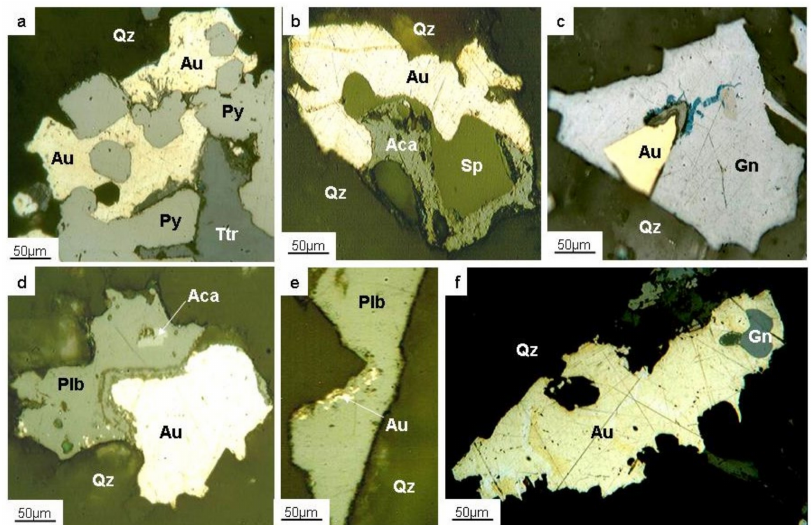
Figure 11. Mineral intergrowths of native gold from ores of gold–silver adularia GIT deposits in quartz: ( a ) with pyrite and tetrahedrite (Dalnee deposit); ( b ) with acanthite and sphalerite (Dalnee); ( c ) with galena (Primorskoe); ( d ) with polybasite and acanthite (Burgali); ( e ) with polybasite (Burgali); ( f ) heterogeneous in fineness of native gold with the inclusion of galena (Kupol deposit). Internal Structures